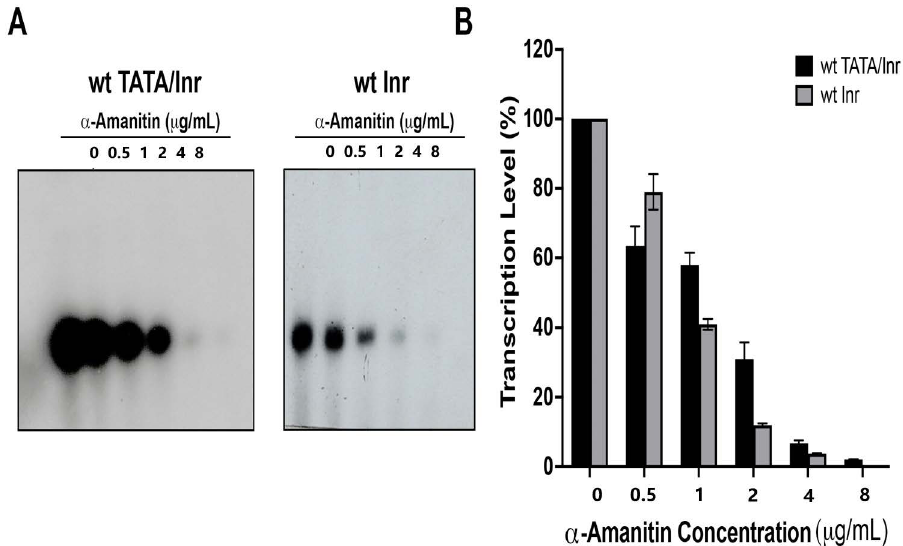
Figure 2. The nmt1 Inr is transcribed by RNAPII in WCE. ( A ) The nmt1 gene promoter containing a TATA box and an Inr is transcribed in WCE, and the transcription is inhibited by α -Amanitin. Concentrations of 0.5, 1.0, 2.0, 4.0, and 8.0 µ g/mL were used to inhibit the transcription of the TATA box Inr-containing nmt1 promoter (wt TATA Inr). It can be observed that concentrations over 4.0 µ g/mL of α -Amanitin completely inhibited the transcription of the wild-type TATA box Inr-containing promoter. On the other hand, concentrations of 2.0, 4.0, and 8.0 µ g/mL of α -Amanitin completely inhibited transcription of the nmt1 Inr-containing promoter (wt Inr). Quantification of the experiments ( n = 3) are shown in ( B ). The intensity of each transcription product was quantified using Image J software. Total pixels of each transcription product were measured and expressed as percentage related to the experiment without the addition of α -Amanitin, which was considered as 100% transcription.